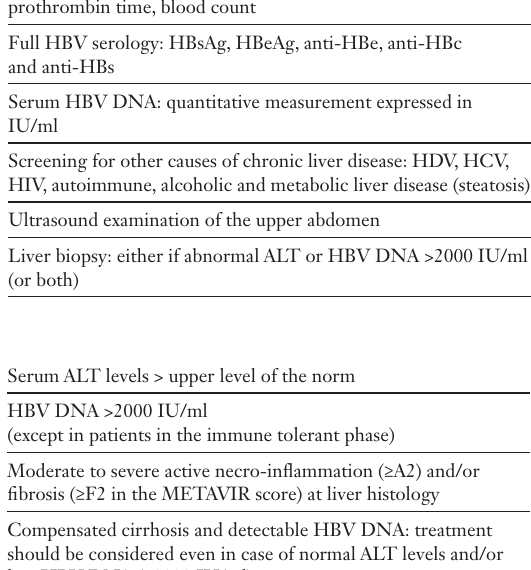
Biochemical markers: AST,ALT, g GT,AP, serum albumin prothrombin time, blood count